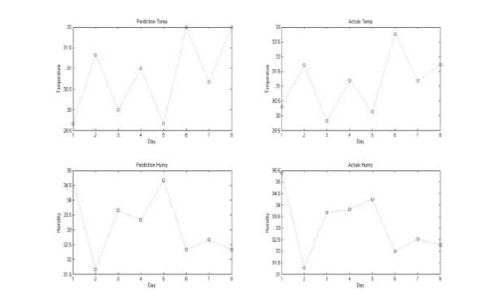
Figure 28. Comparison of predicted temperature and humidity values in node 1 with actual logged values.